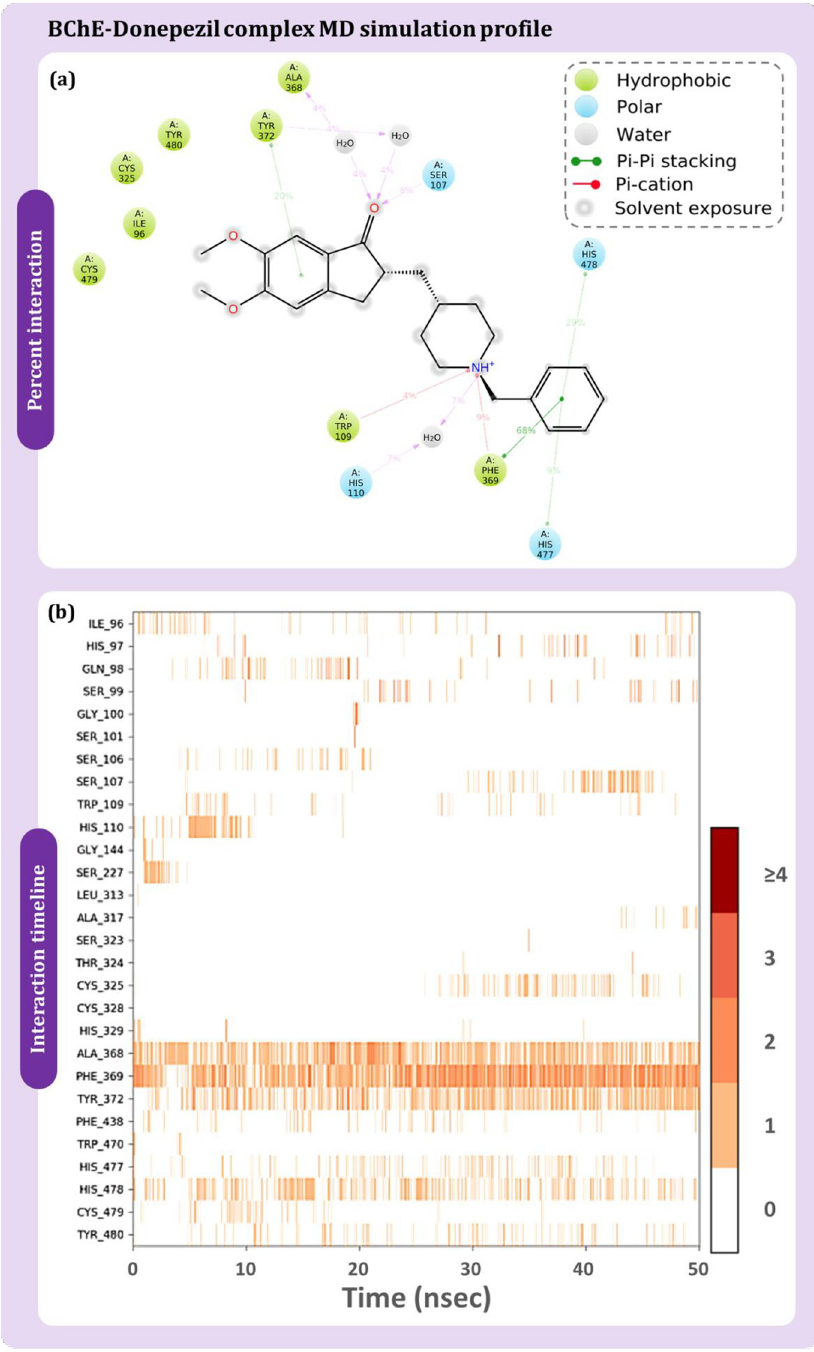
Fig 10. BChE-donepezil (a) percent interaction profile and (b) interaction timeline profile obtained on performing 50 ns MD simulation.